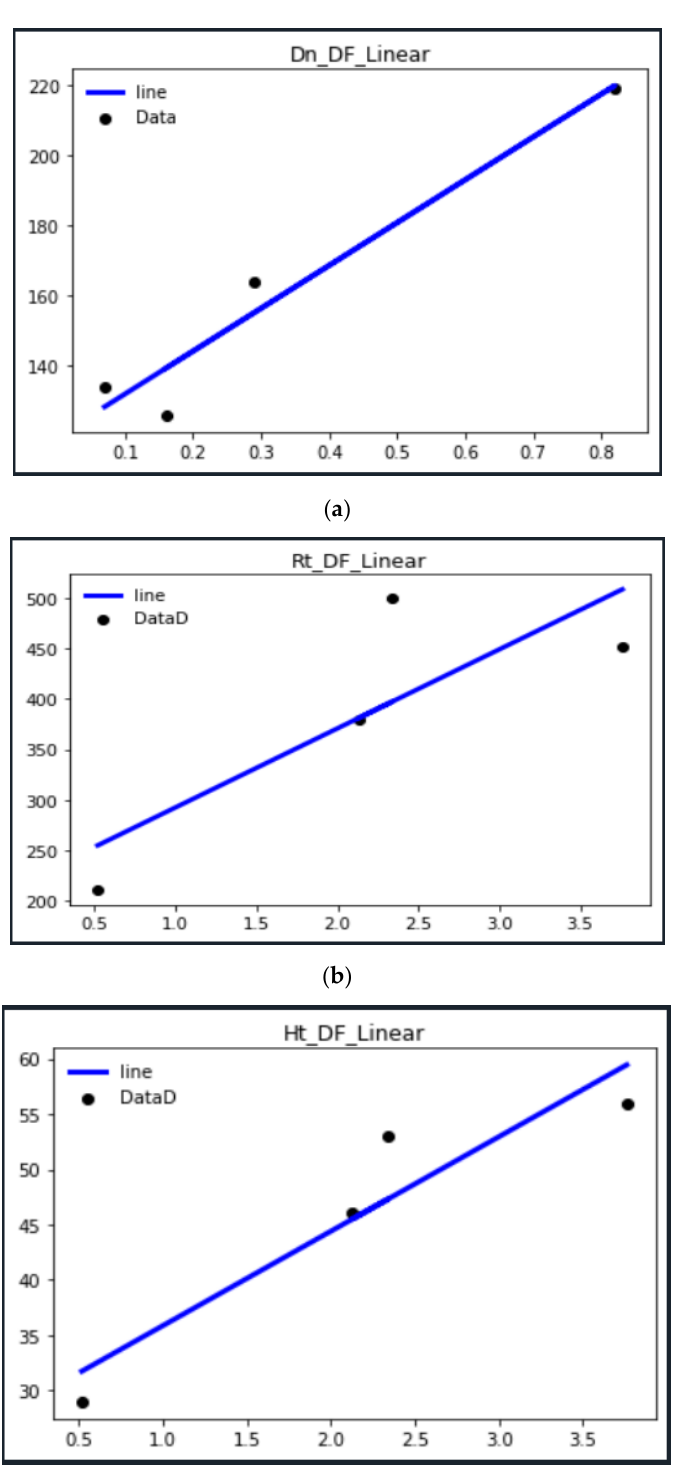
Figure 20. ( a ) Diagram of fitting 𝐷 𝑛 data ( b ) Diagram of fitting 𝑅 𝑡 data ( c ) Diagram of fitting 𝐻 𝑡 data